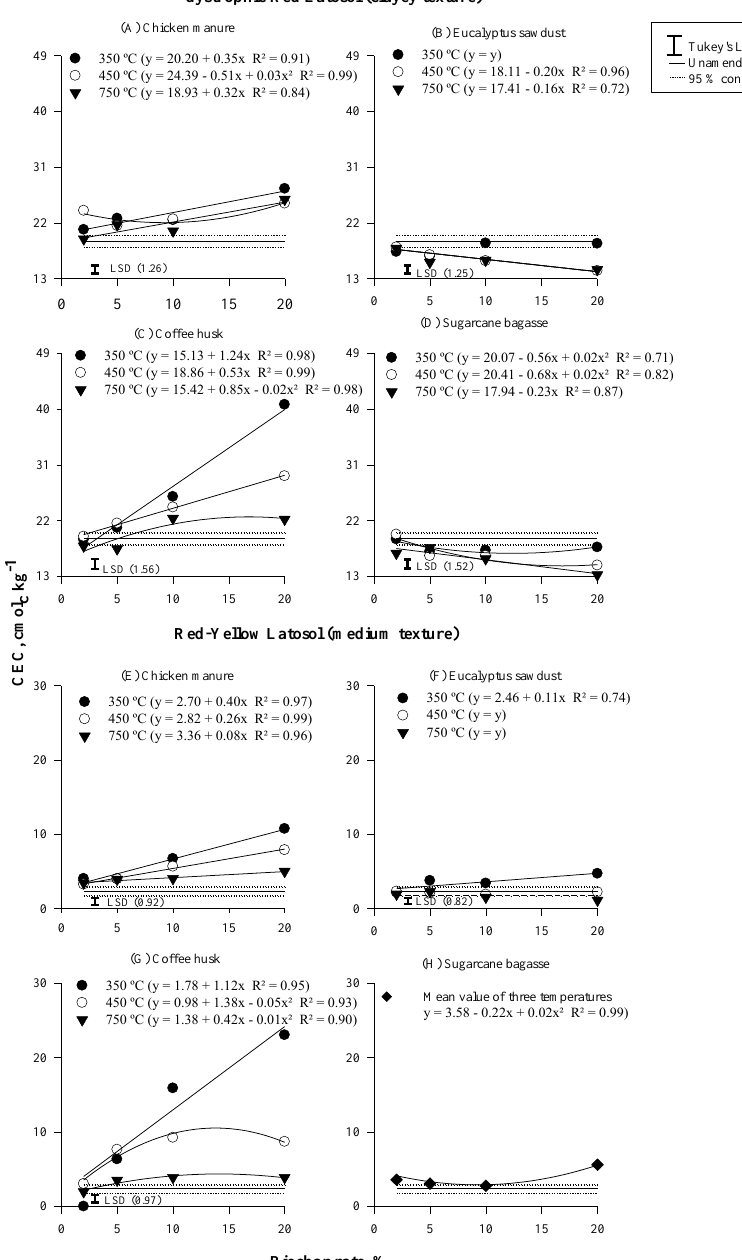
Figure 1. The CEC of the RedLatosol (clayey texture) and Red-Yellow Latosol (medium texture) as a function of biochar rates of chicken manure (A, E), eucalyptus sawdust (B, F), coffee husk (C, G) and sugarcane bagasse (D, H) pyrolyzed under different temperatures, after 9 months of incubation. Tukey’s Least Significant Difference (LSD) ( p < 0.05).